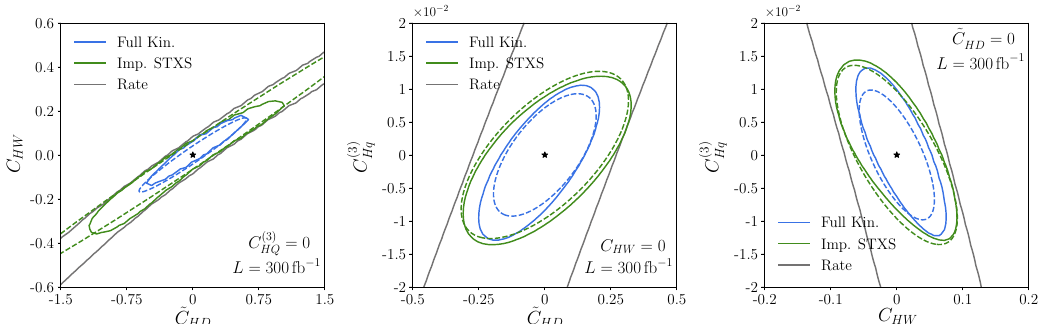
Figure 8 . Expected exclusion limits at 95% CL based on a rate-only analysis (grey), from the improved STXS (green), and from a multivariate analysis of the full phase-space information with the Sally algorithm. We show (linearized) limits based on the Fisher information (dashed) and full exclusion limits that take into account the e(cid:11)ects of linearized and squared new physics e(cid:11)ects (solid). In each panel, we set the operator not shown to